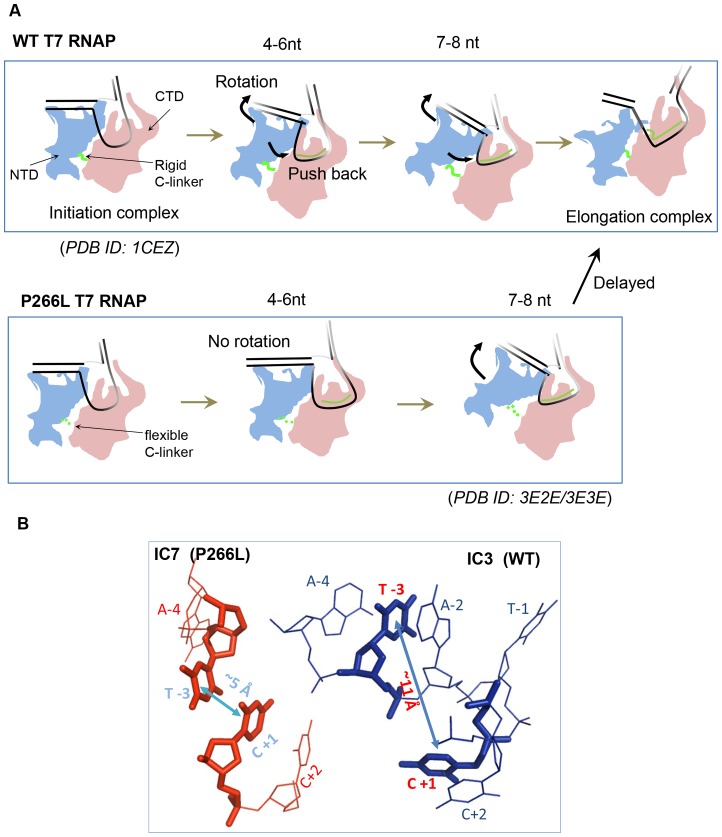
Distinct transcription initiation pathways of WT and P266L T7 RNAP.(A) The transcription initiation pathways of WT T7 RNAP (top) and P266L T7 RNAP (bottom) are shown in cartoon format to illustrate the distinct intermediate conformations. The N-terminal domain is shown in blue, C terminal domain in red, DNA in black and RNA in green. Movement of the N terminal domain is marked by the arrow. Both WT and P266L T7 RNAP bind, bend, and open the promoter DNA from −4 to +2 to the same extent. The rigid C-linker of WT favors progressive rotation of the upstream end of the promoter to accommodate the growing hybrid from +4 to +6 positions, which pushes against the N-terminal domain driving the rotation of the promoter. The pushback from the N-terminal domain destabilizes the RNA:DNA hybrid and leads to abortive synthesis in WT. The flexible C-linker of P266L mutant (bottom panel) accommodates RNA extension up to 6 nt without significant promoter/N-terminal domain rotation. The reduced DNA scrunching together with the absence of promoter rotation in the 4–6 nt RNA range in P266L suggests that the growing hybrid is accommodated by an alternative pathway. After 6 nt RNA synthesis, promoter rotation and scrunching resumes in P266L. The weakened promoter interactions in WT after 9 nt RNA synthesis allow release of the N-terminal domain and transition into elongation. Persistent promoter interactions delay the transition in P266L. (B) Template strand scrunching in P266L RNAP with 7 bp RNA:DNA. Template strand from the IC3 (PDB: 1QLN) and IC7 (PDB: 3E2E) crystal structures showing decrease in the distance between C+1 and T-3 in the IC7 structure (brown) compared to the IC3 structure (blue).